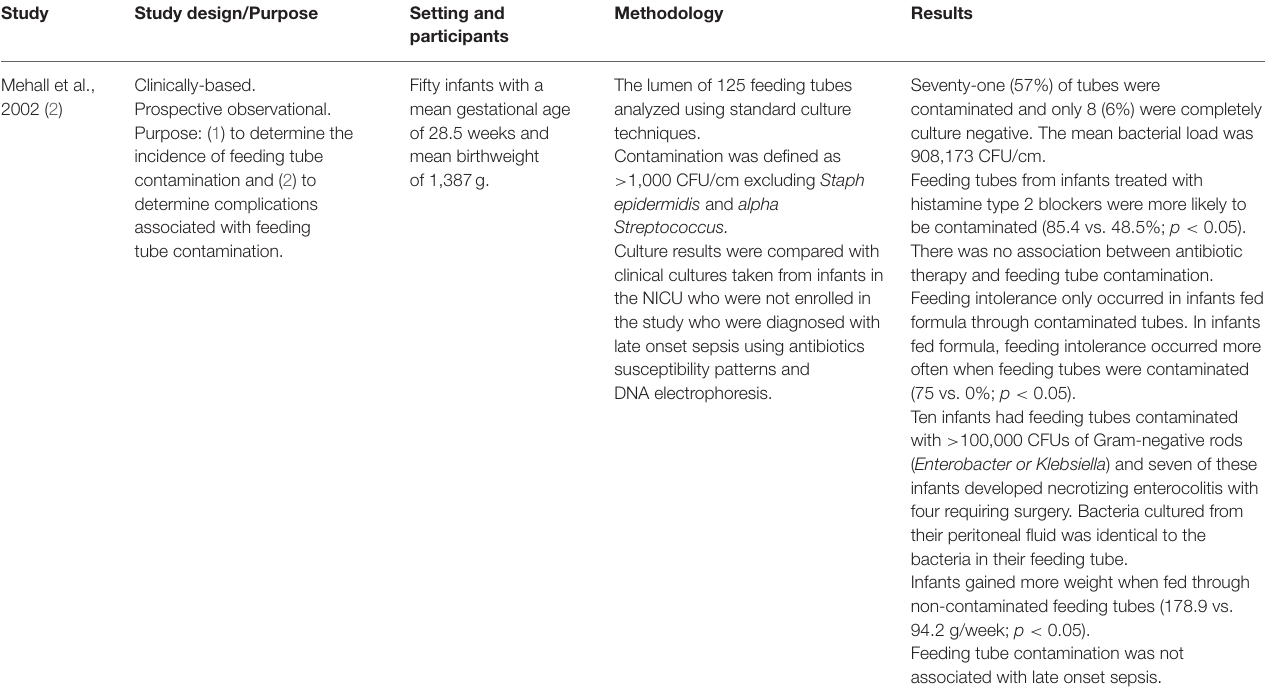
TABLE 1 | Summary of included